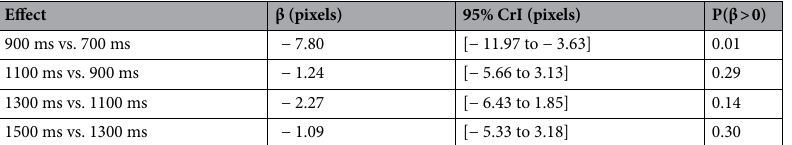
Table 3. Contrast estimates of the interception location for consecutive temporal intervals. Positive values indicate that the response location was more shifted towards in the movement direction of the circle (overshooting) than for the previous temporal ISI